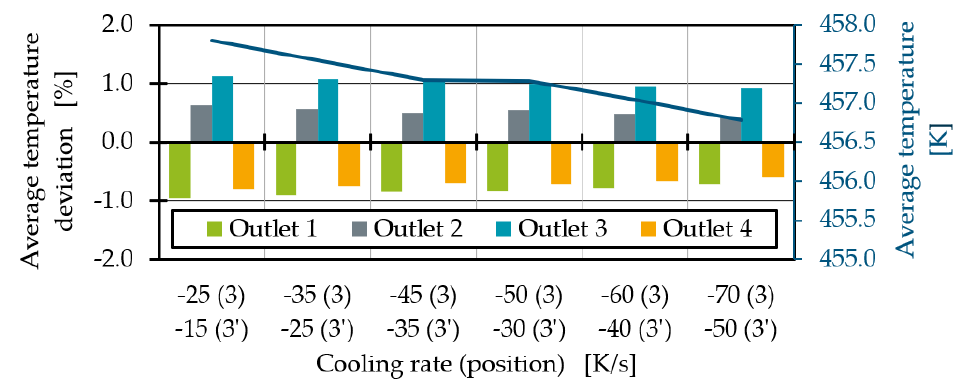
Figure 17. Average temperature deviation for two heat pipes with different performances at position